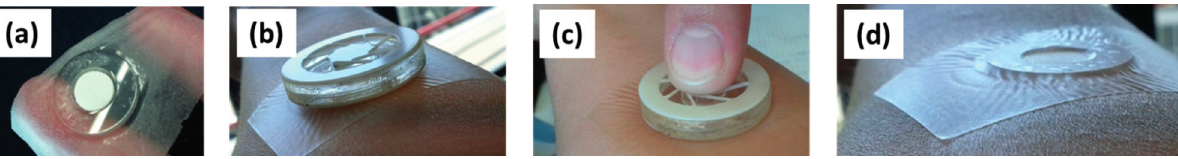
Figure 5. ( a ) npMNA patch assembled with guidance ring and adhesive; ( b ) MNA patch (emulated by a ceramic disc only) fixed with the guidance ring and the adhesive to the forearm of a volunteer with the first conceptual applicator atop; ( c ) The applicator assisting npMNA insertion pushing onto the piston; ( d ) The inserted